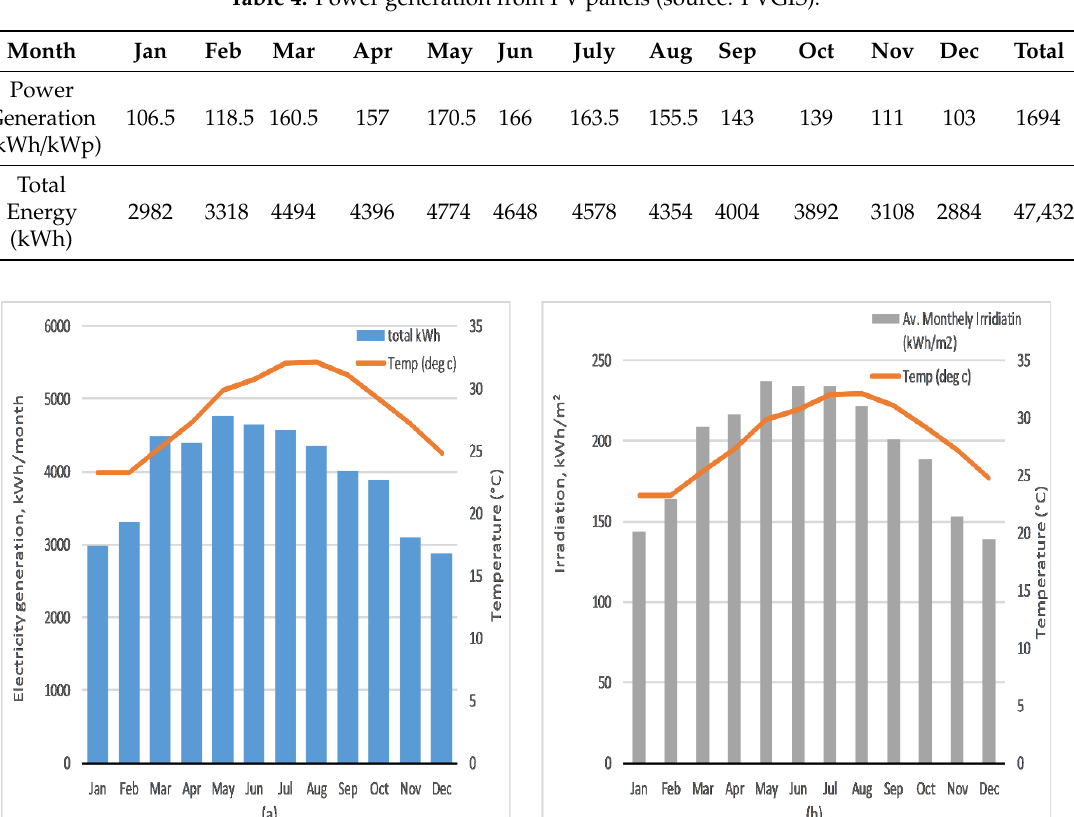
Table 4. Power generation from PV panels (source: PVGIS).